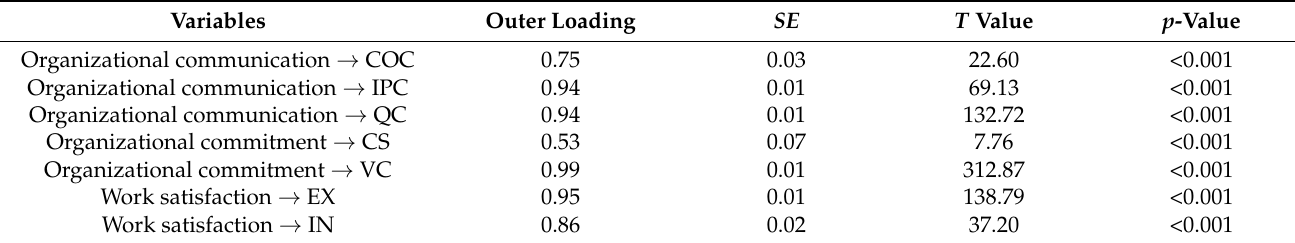
Table 4. Test of second-order models using bootstrapping.